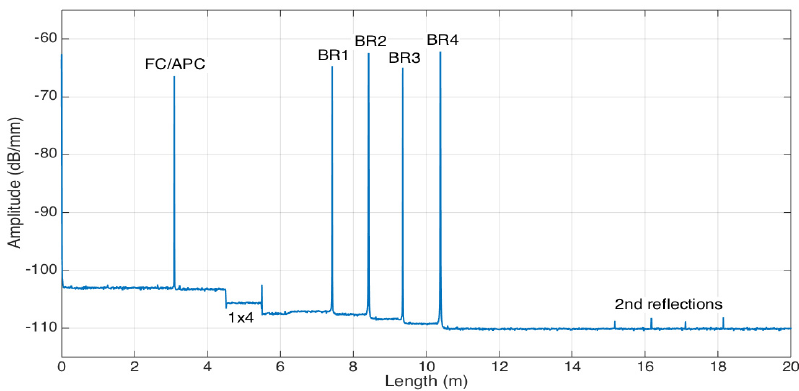
Figure 4. Reflectivity trace of the multiplexed BR sensing architecture; the chart reports the amplitude of the reflected signal as a function of the length, highlighting the position of the lead FC/APC connector, the 1 × 4 splitter, the 4 BR sensors, and the second-order reflections visible at >15 m distance. By integrating over a short window, correspondent to each reflectivity peak, and